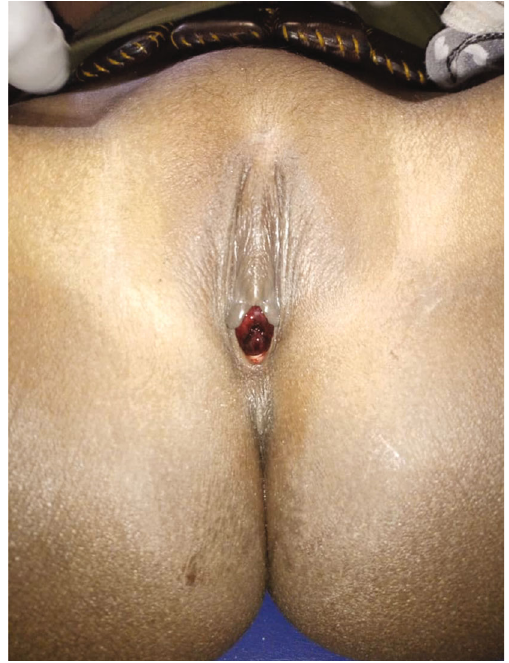
Figure 1: Blood at the meatus of a urethral prolapse in a 7-year-old